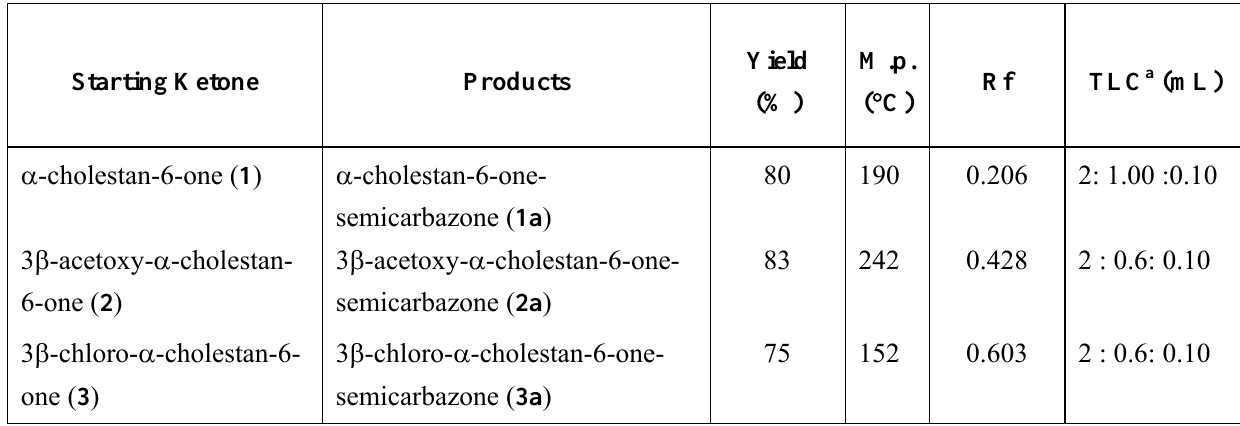
Table I. Physical properties of the semicarbazones 1a - 3a